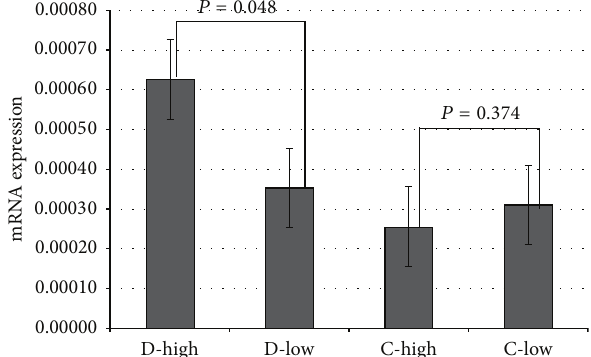
Figure 1: PPARG mRNA expression in blood total leukocytes from VO 2 max discordant and concordant MZ twins. mRNA expression is shown as Δ Ct values in relation to GAPD (reference gene). Results between low and high VO 2 max within discordant (D-low versus D- high) and concordant (C-low with C-high) pairs were compared by paired Wilcoxon